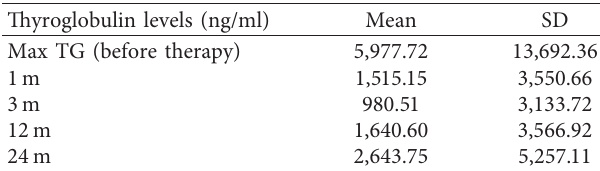
Table 3: Thyroglobulin levels (mean ± SD) at different time